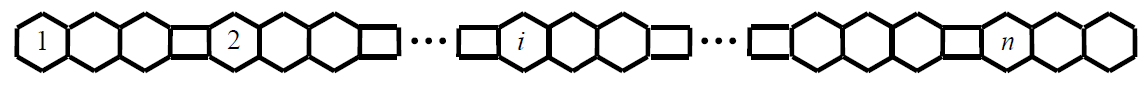
Figure 2: The molecular graph of linear [ s ] -Anthracene.